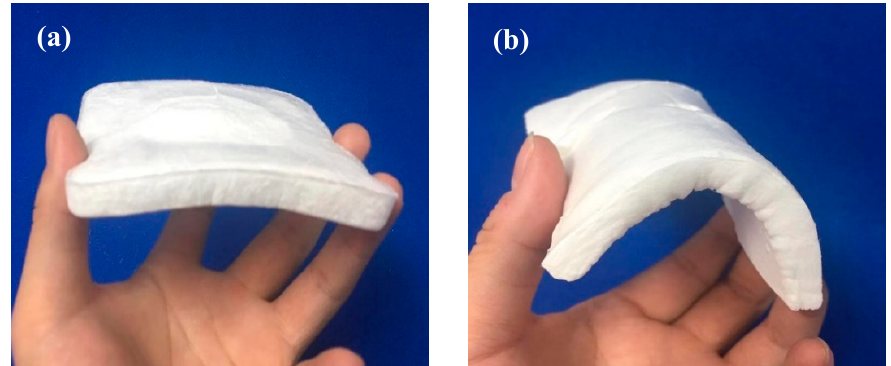
Figure 6. Optical images of the ( a ) HCNF aerogel, and ( b ) HCNF/APP/MTMS aerogel with different features.